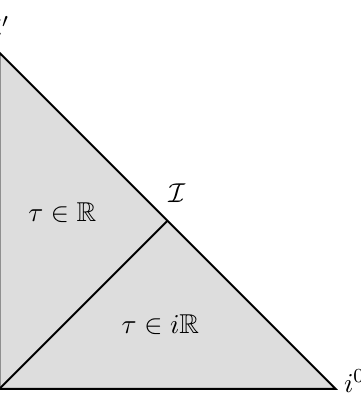
Figure 1 . The toric Penrose diagram for signature (2 , 2) Klein space. A Lorentzian torus is fibered over every point on the diagram, except the left vertical edge where one cycle degenerates to zero length and the bottom edge where the other cycle degenerates. Null geodesics at a i 0 labels spatial infinity and i 0 timelike infinity. I labels null infinity, which is a Lorentzian torus fibered over a null interval. The spacetime divides into an upper and lower wedge characterized by the sign of τ 2 = − x µ x µ